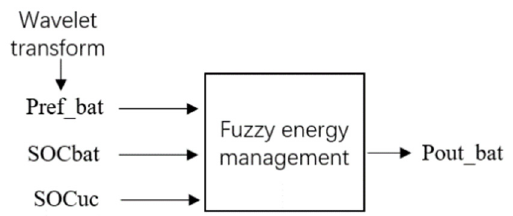
Figure 11. Control diagram of the lithium battery output power.